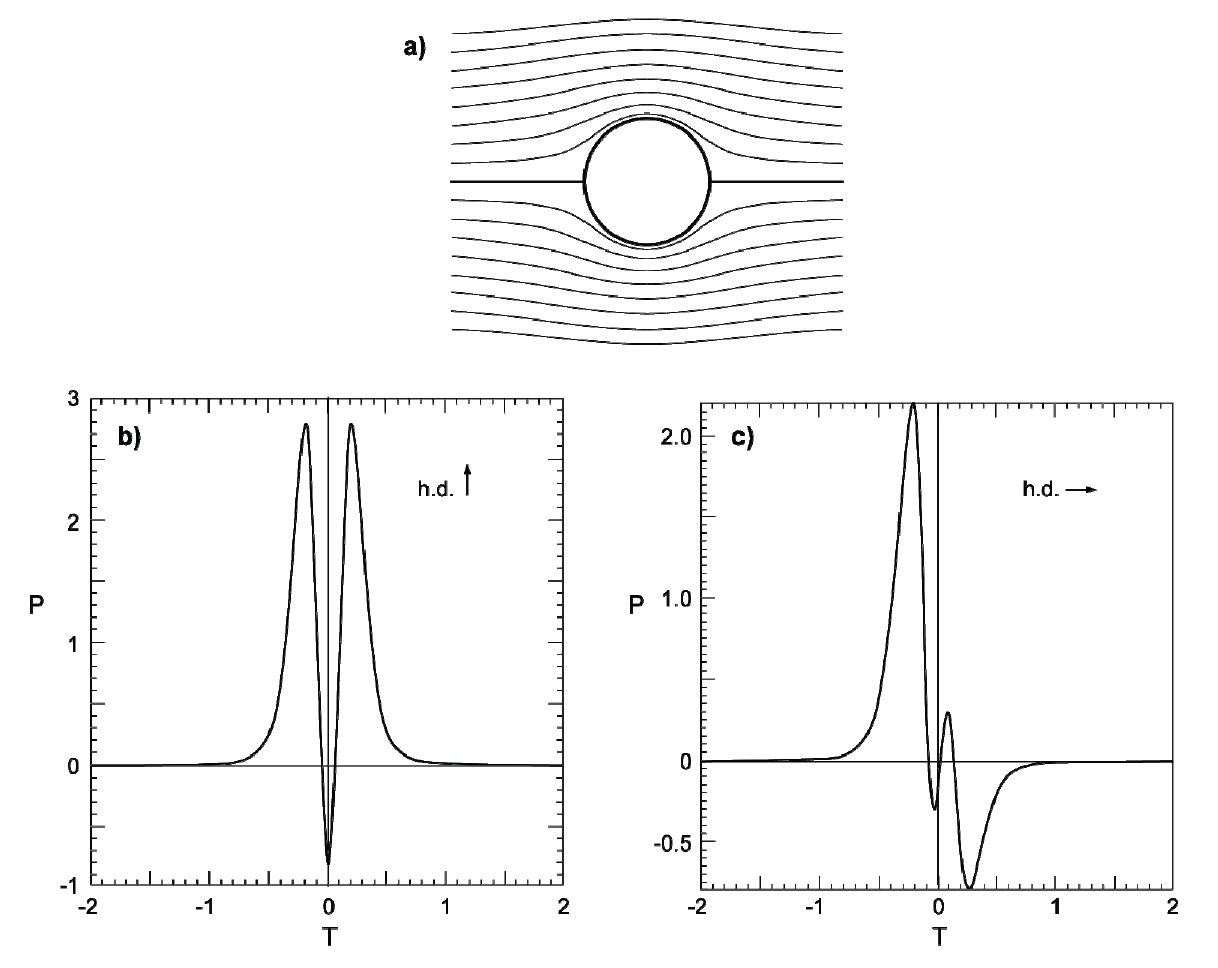
Figure 1. Vortex and entropy noise pulses. The second theory of aerodynamic sound explains sound emission by: (i) vorticity that is “vortex” sound; (ii) fluid inhomogeneities or patches of unburned gas, that is “entropy noise”. The vortex is subject to a vortical force unless the vorticity is alligned with streamlines, for example when it is convected past a body. The fluid inhomogeneity is subject to a compression force in a pressure gradient because its density is distinct from the surrounding flow. Both forces act as dipoles radiating a sound pulse when convected past a body that causes a non-uniform flow. Besides the direct wave radiated by the vortex (VD) or blob (BD) to the observer, there is a wave (respectively VR and BR) reflected by the body. The reflected wave is also a dipole, due to the pressure distribution of the incident wave on the body, and thus is comparable in magnitude to the direct wave. The second theory of aerodynamic sound accounts for both the direct wave and that reflected by the scattering body that causes the non-uniform flow when placed in a stream. In the case illustrated [68] the fluid inhomogeneity is convected past a cylinder ( a ) and the sound pulse has a different shape depending on the observer position in the far-field; the sound pulse is symmetric when received in the in the sideline position ( b ) and unsymmetric when received in the downstream ( c ) direction. In the case of a helicopter rotor there is periodic train of pulses due to each rotor blade interacting with the wake of the preceding, leading to blade-vortex interaction noise (Figure